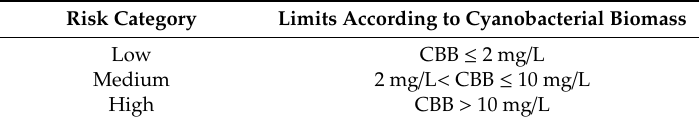
Table 3. The three risks to human health categories for the recreational use of lakes according to cyanobacteria